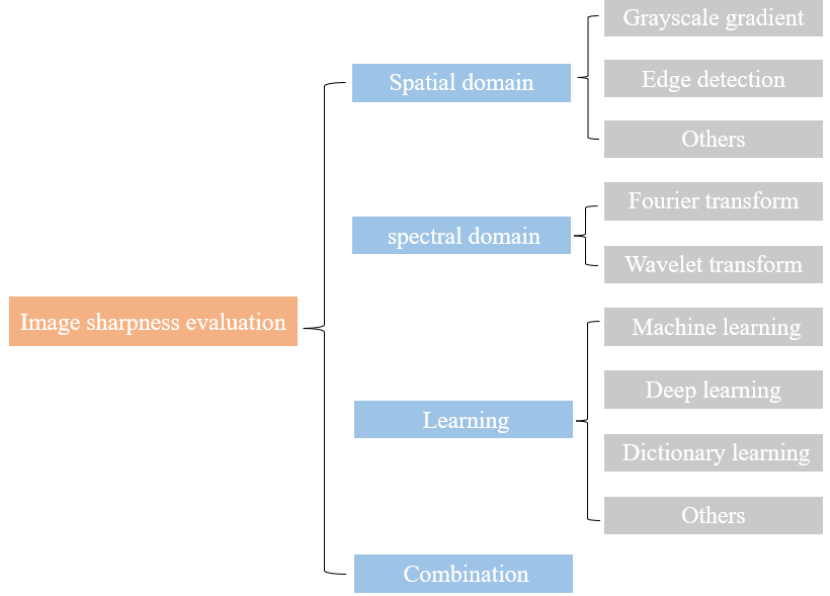
Figure 1. Image sharpness evaluation classification.